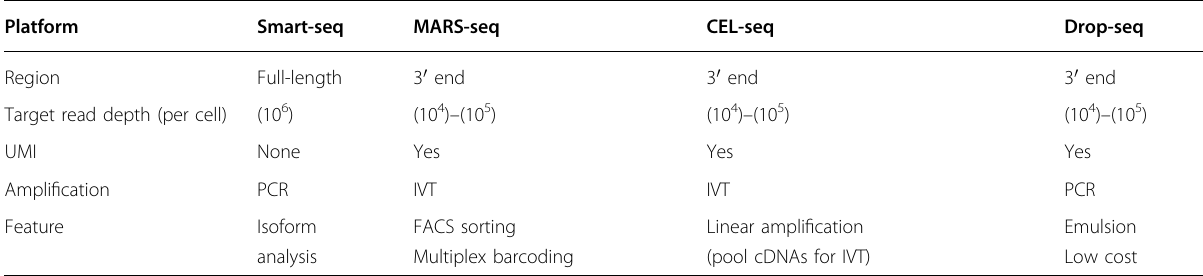
Table 1 Comparison of scRNA-seq library preparation methods Platform